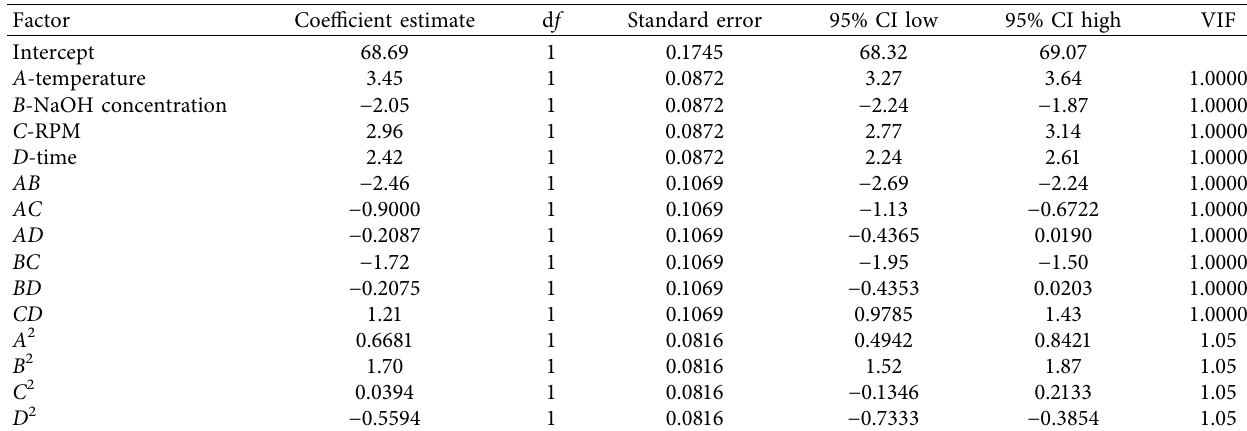
Figure 4: (a) Predicted versus actual yield of silica. (b) Normal plot of residuals. Table 5: Coefficients in terms of coded